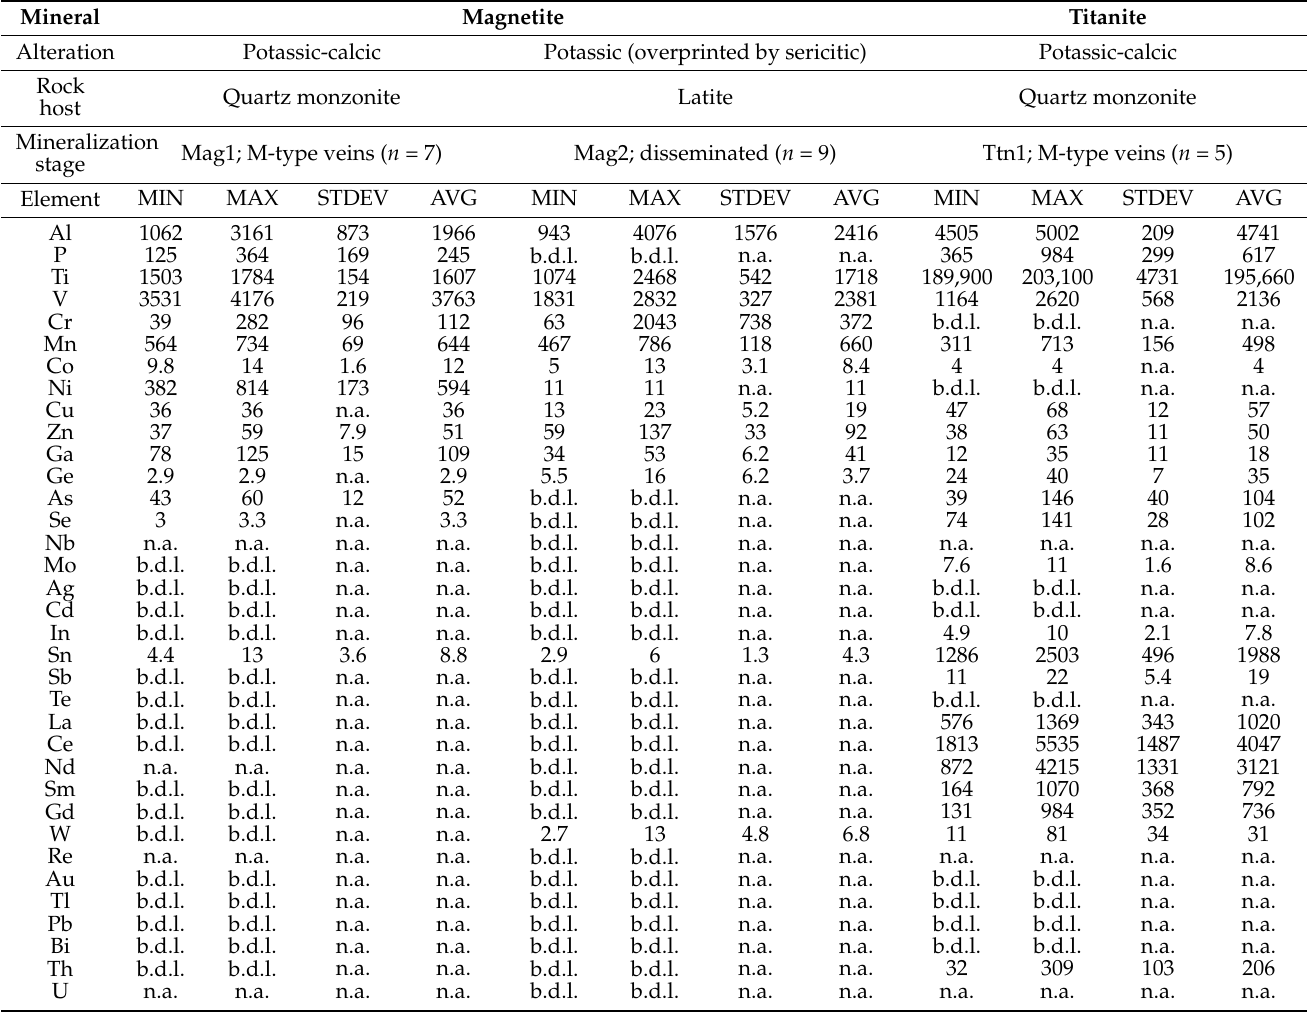
Table 5. LA-ICP-MS analyses of magnetite and titanite from various mineralization stages. Values are in ppm. For the full dataset, see Supplementary Table